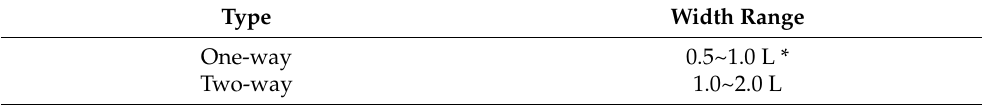
Table 3. Criteria for fairway width according to the Port and Fishing Port Design